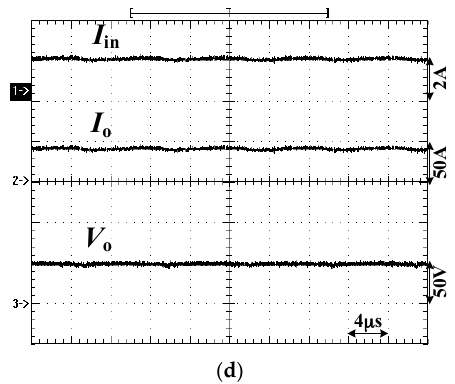
Figure 9. Test results of the output-side currents at 100% load ( a ) i D 1 , i D 2 , i Lo and i Cp ( b ) i Lo , i FB , i Dp 1 and i Dp 2 ( c ) i D 3 , i D 4 and i LLC ( d ) input current I in , load current I o and load voltage V o .